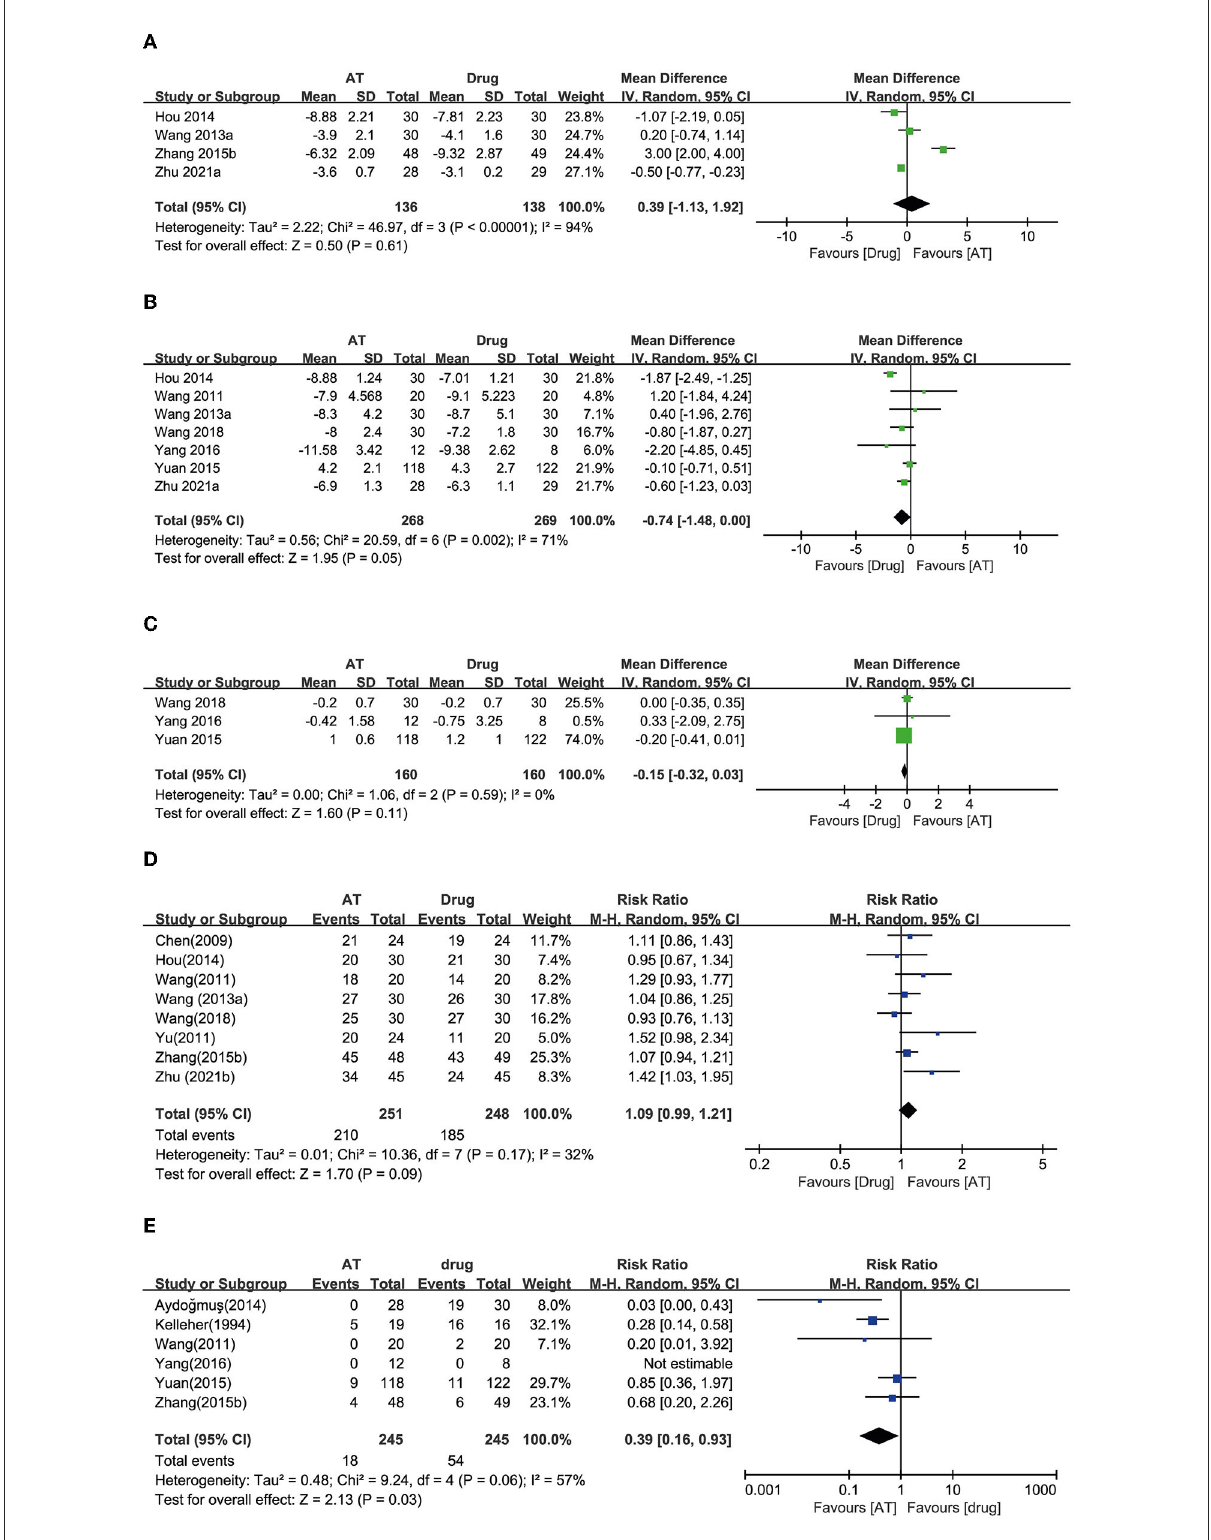
FIGURE4 Forest plot of (A) OABSS, (B) frequency, (C) incontinence, (D) response rate, and (E) adverse effects according to the comparison of AT vs. drug